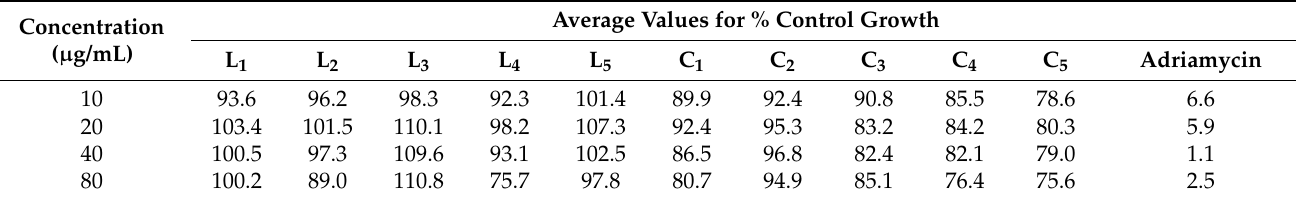
Table 10. Average values for % control growth for the lung cell line A-549.